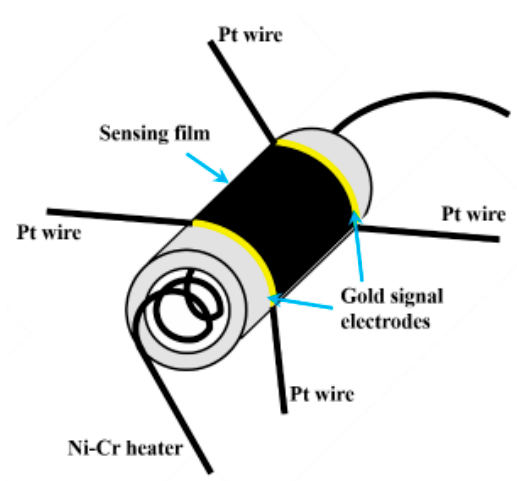
Figure 2. Schematic diagram of the device for gas sensing performance testing.